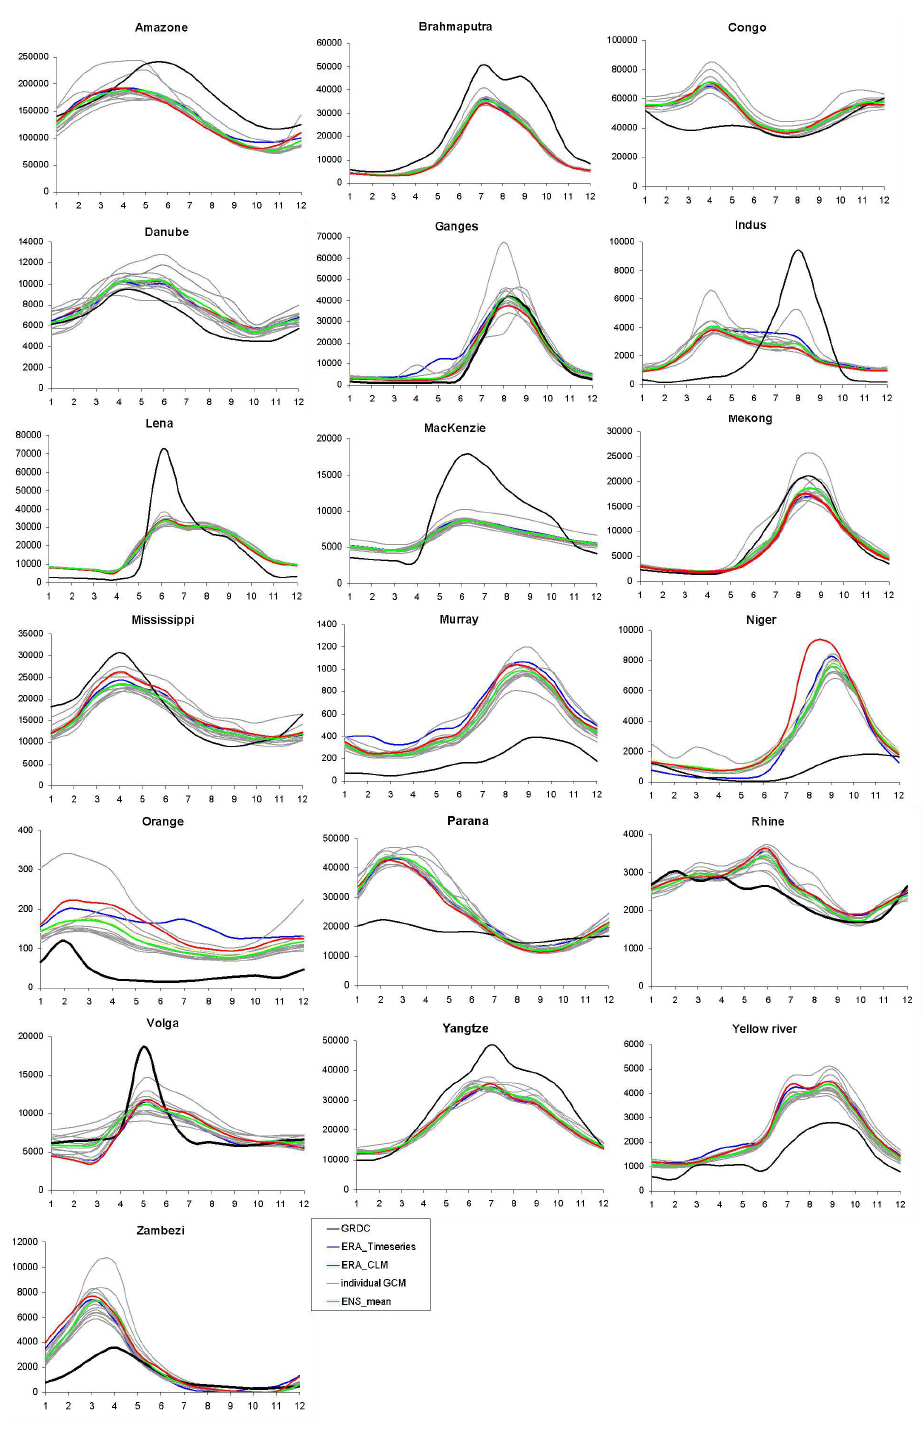
Figure 14: Hydrological regimes for all 19 catchments derived from discharges calculated for the period 1961–1990, with the average monthly discharge (m 3 /s) on the y-axis and the month numbers on the x-axis. Black line is annual mean observed discharge (GRDC), grey lines are PCR-GLOBWB based on individual bias-corrected GCM datasets, green line is ensemble mean result, blue line is derived from PCR- GLOBWB run forced with the ERA6190 dataset and red line is derived from PCR-GLOBWB run forced with the ERACLM dataset.